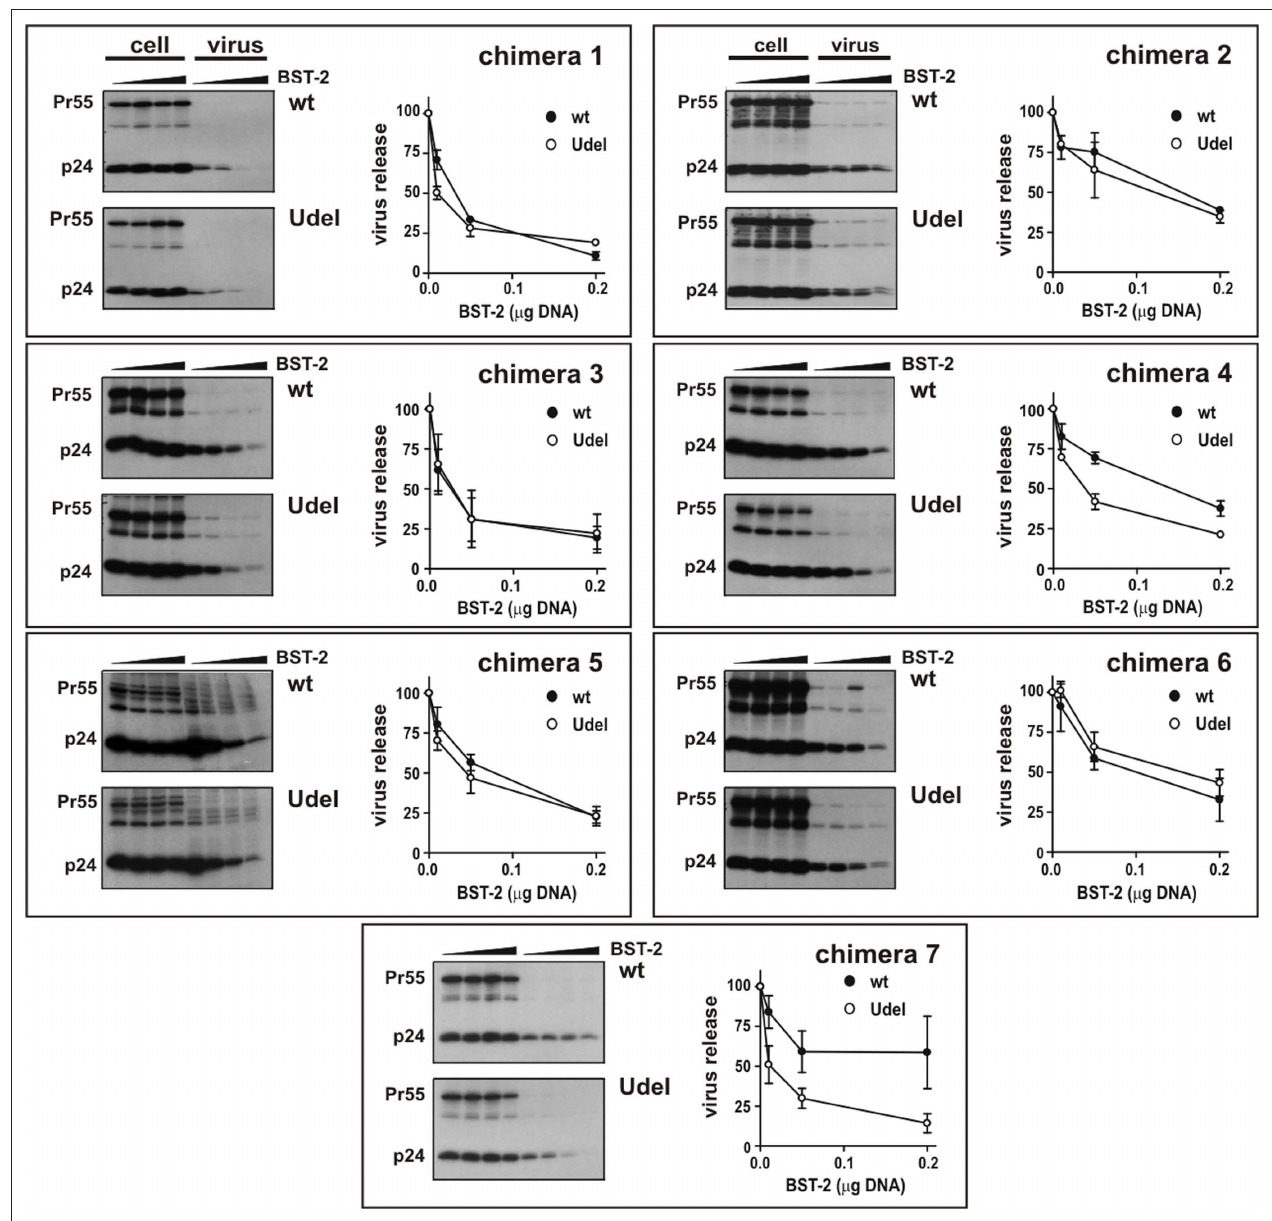
FIgure 4 | Analysis of rhesus BST-2 carrying the TM domain of human BST-2 for susceptibility to HIV-1 Vpu. 293T cells were transfected with 5 μg of either pNL4-3 (wt) or pNL4-3/Udel (Udel) in the absence of BST-2 or in the presence of 0.01, 0.05, or 0.2 μg BST-2 chimeric constructs as described for